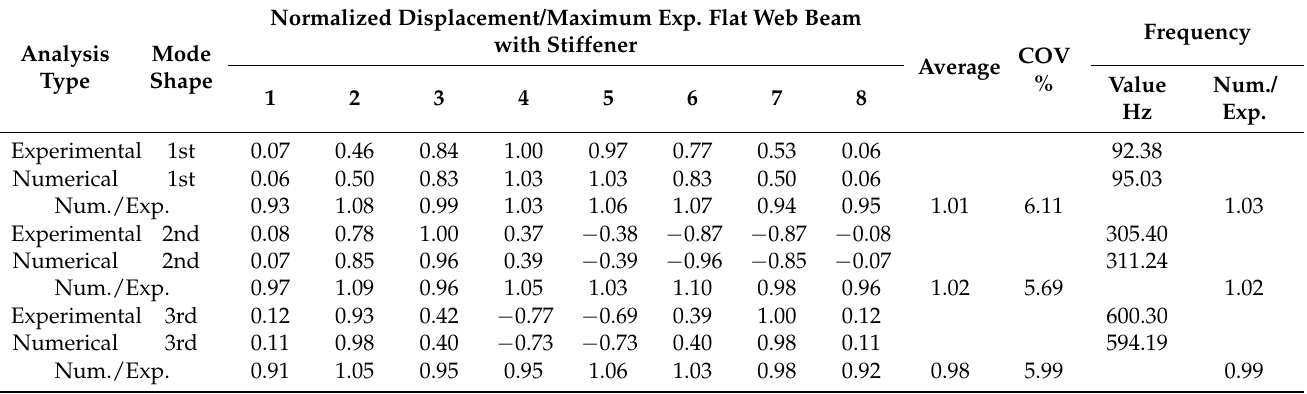
Table 3. Comparison of experimental and numerical results for the flat web beam with